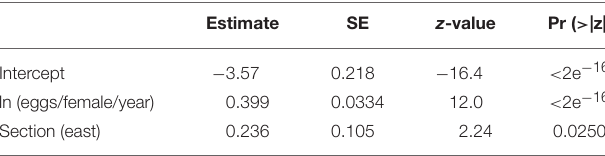
Summary table for the weighted glm (roadside proportion ∼ ln(eggs/yr) + section, family = binomial) where “roadside proportion” is the proportion of adult frogs of a species found at roadside traps against the average number of eggs laid by a female of that species per year. Null deviance: 359.66 on 30 degrees of freedom. Residual deviance: 195.87 on 28 degrees of